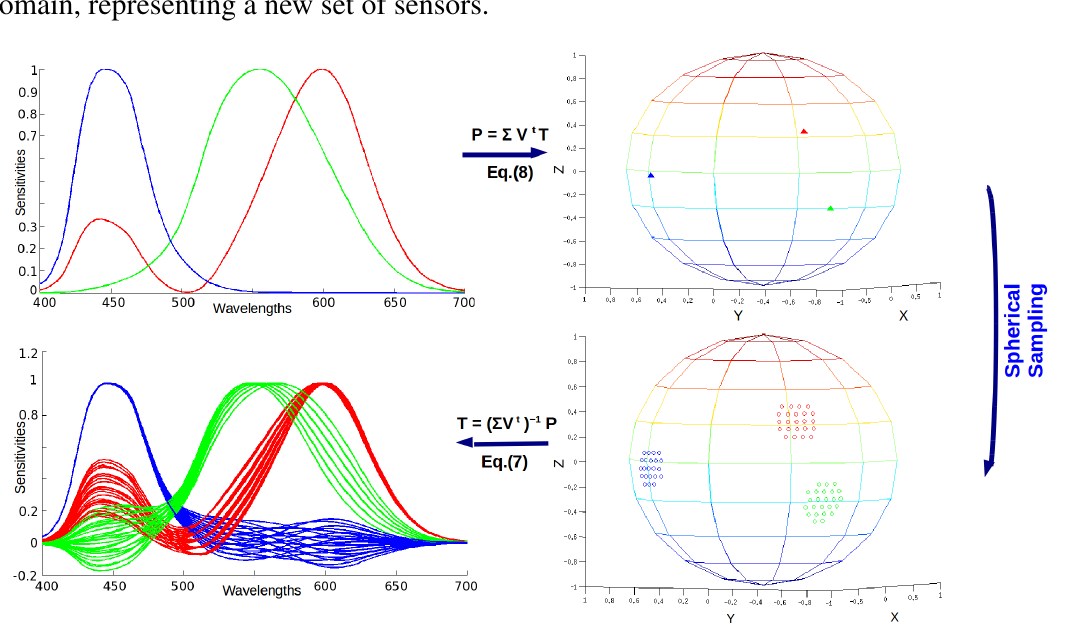
Figure 2. Pipeline of the spherical sampling method. Adapted from [11]. From the original set of sensors, representatives in the sphere are obtained. Then, a sampling over those points in the sphere is performed. Finally, all of the points added are transformed back to the sensor domain, representing a new set of